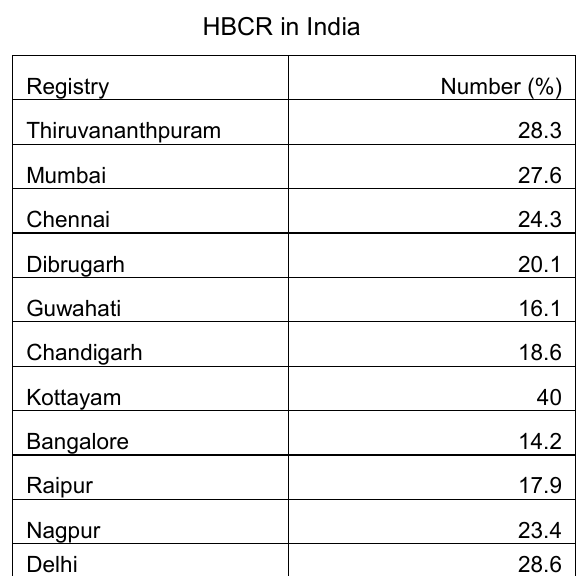
Figure 6. Number of cases registered in various Table 2. Number of cases registered in various